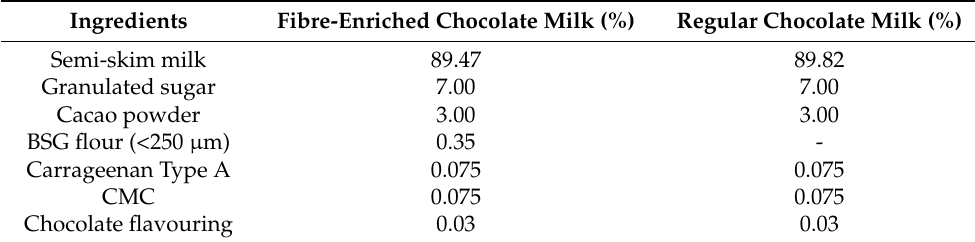
Table 3. Formulations of the fibre-enriched chocolate milk and regular chocolate